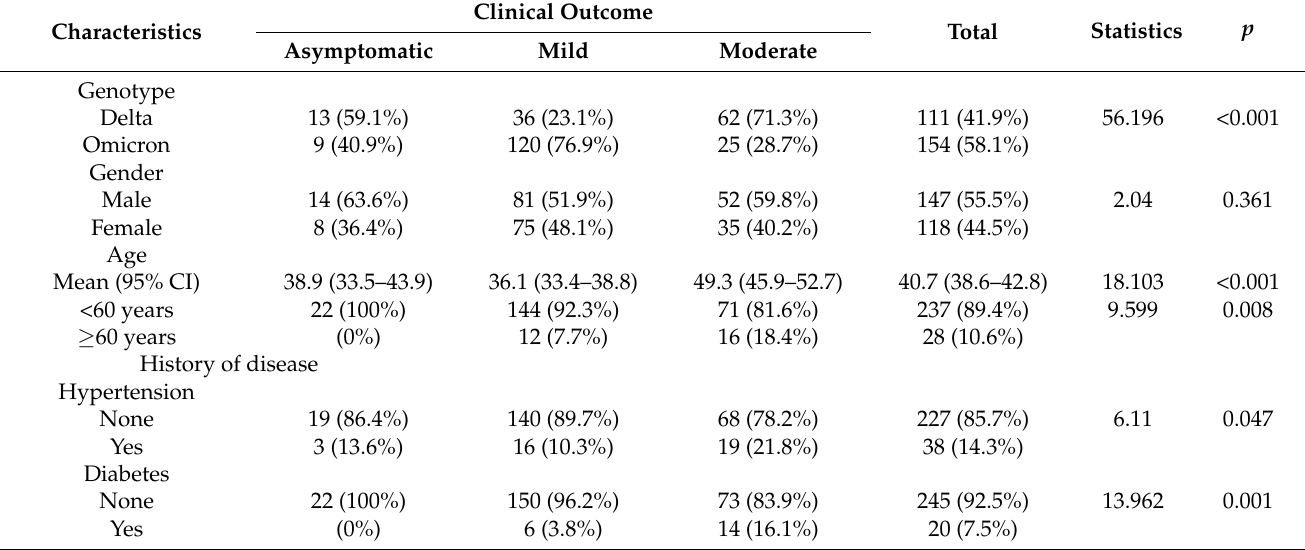
Table 1. Characteristics of the study